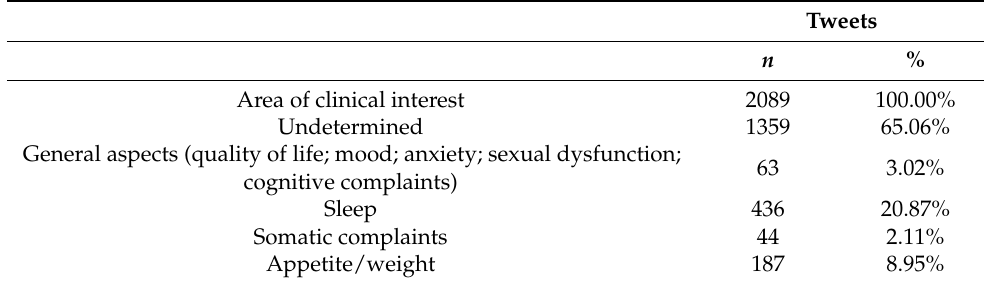
Table 1. Number and percentage of tweets by area of clinical